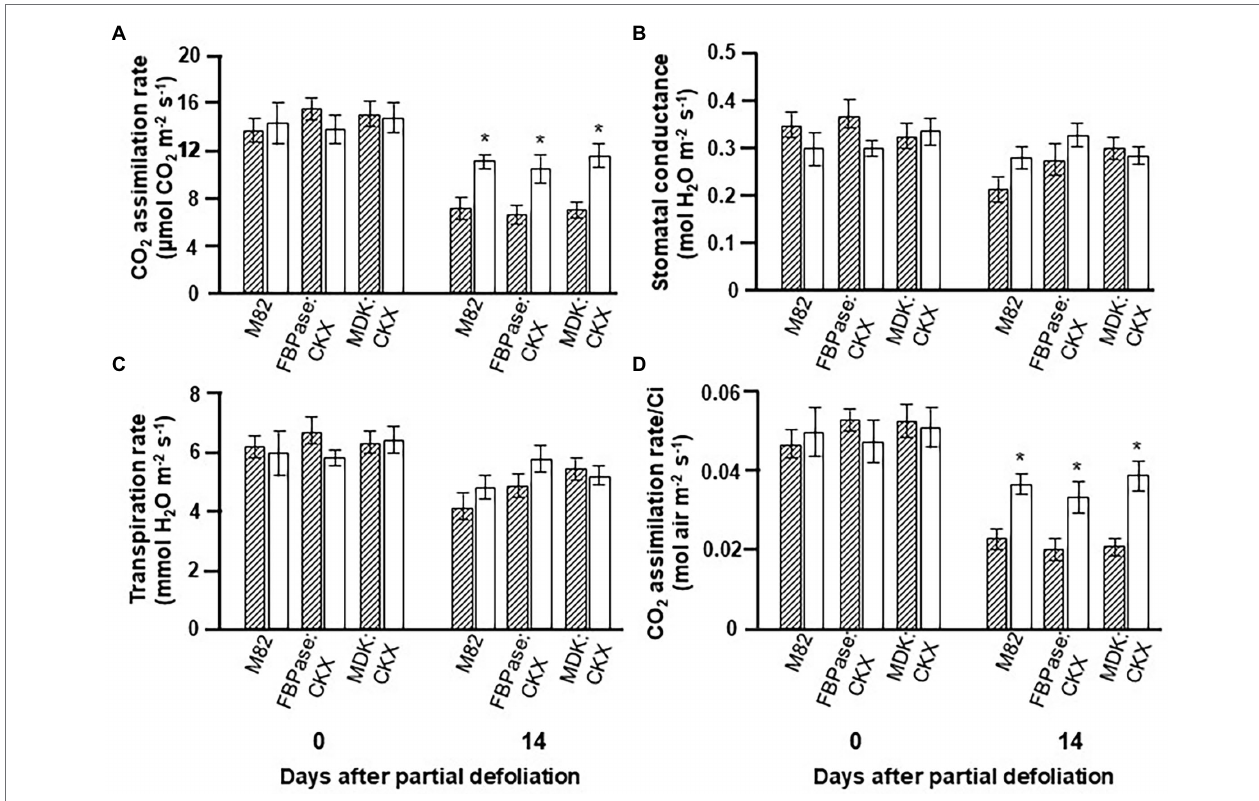
FIGURE 2 | Effect of reduced cytokinin biosynthesis on the photosynthetic activity response to partial defoliation. Photosynthetic rate (A) , stomatal conductance (B) , transpiration rate (C) , and rate of photosynthesis per internal CO 2 concentration (Ci; D ) of source leaves in nondefoliated plants (hatched bars) and the remaining tomato leaves after partial defoliation of the other leaves (empty bars). Defoliation was performed on mature plants at the reproductive stage of variety M82 and transgenic tomato plants expressing CKX under FBPase (FBPase:CKX) or AtMDK (MDK:CKX) promoters. Plants were grown in a temperature-controlled greenhouse (25 ° C/18 ° C day/night). Student’s t -test was used to compare mean values of six plants. Asterisks indicate significant differences between partially defoliated and nondefoliated same tomato line at p <